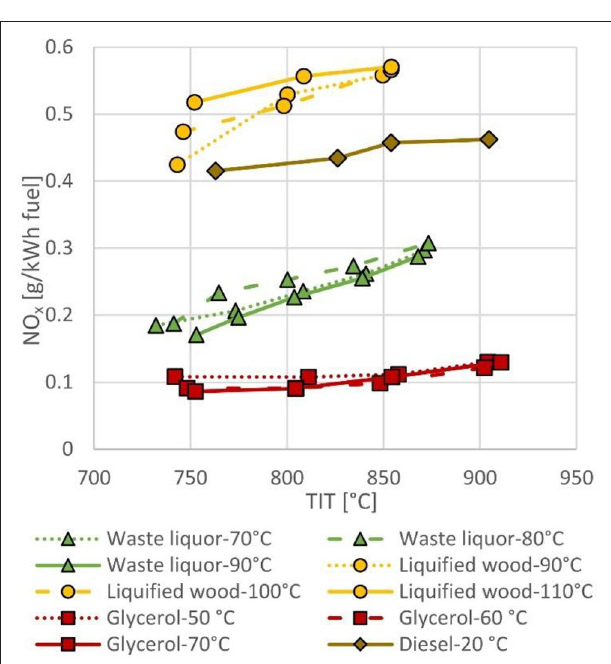
FIGURE 9 | NO x emissions for different fuels at different fuel temperatures.